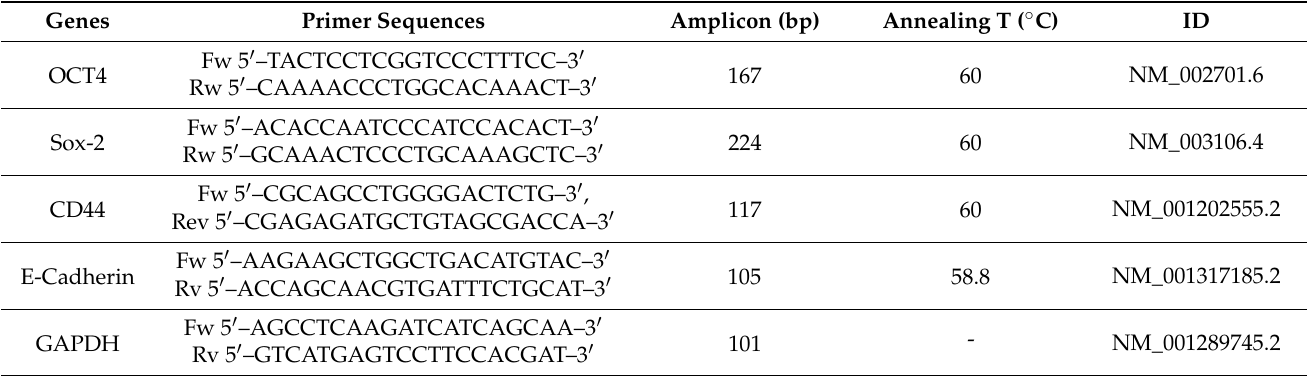
Table 1. Human primer